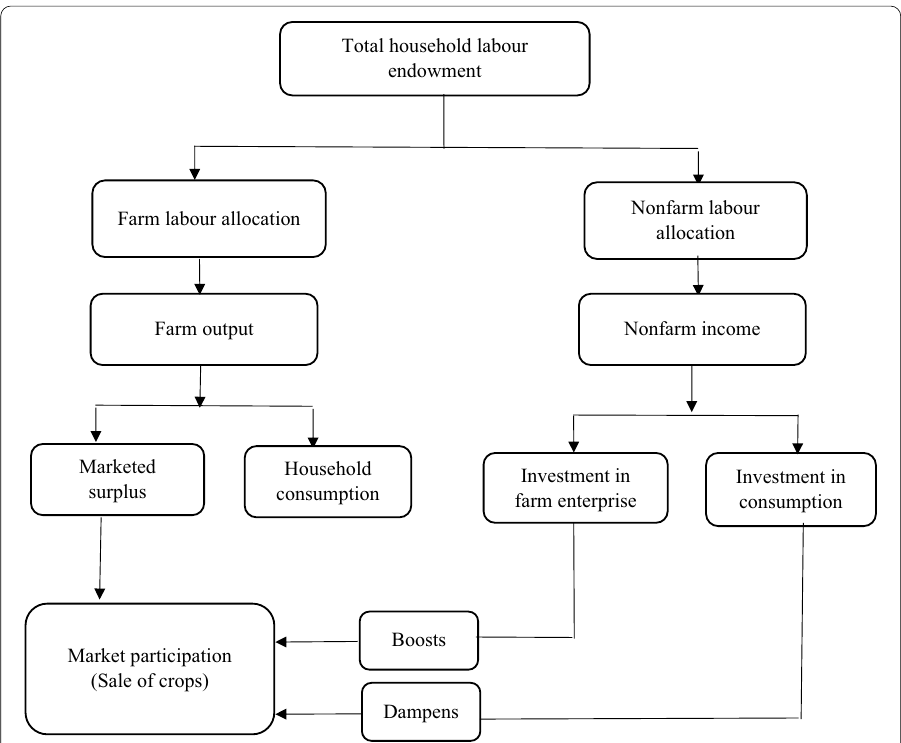
Fig. 1 Conceptual model of nonfarm engagement effect on market